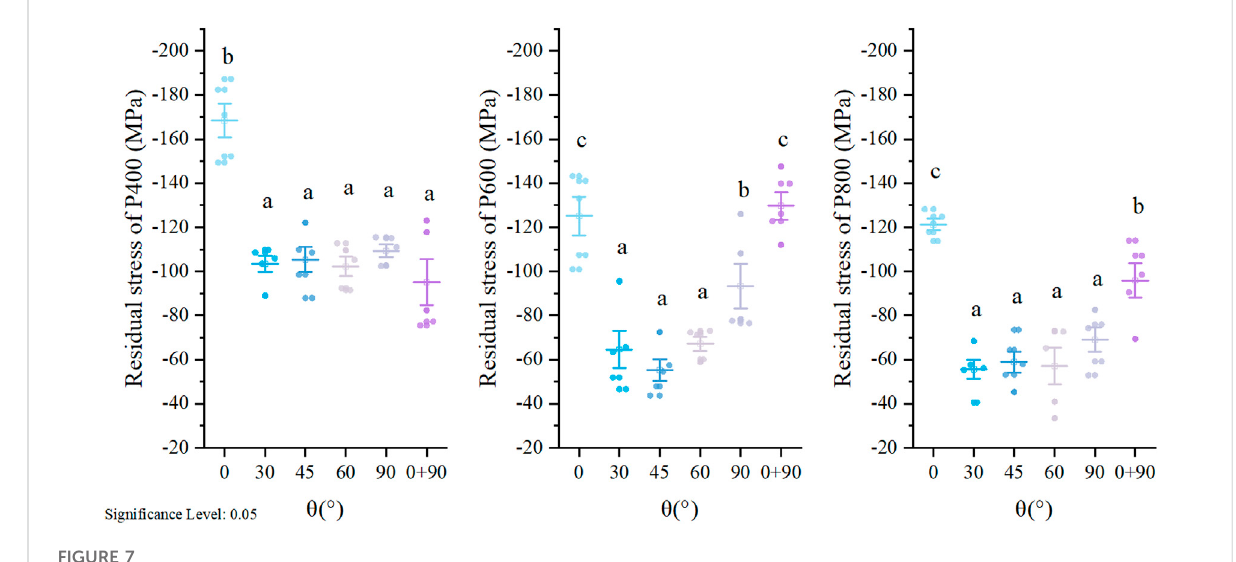
FIGURE 7 Post hoc comparison of results for surface residual stresses.